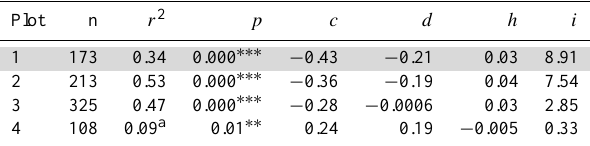
Table 5. Descriptive and ANOVA statistics are shown for soil res- piration values along the disturbance gradient. The grey highlighted lines show the disturbed plot where the non-highlighted values rep- resent the undisturbed plots. Differences in average plot respiration were significant in the wet season 2008. Plot 4 was observed in 2009 only.